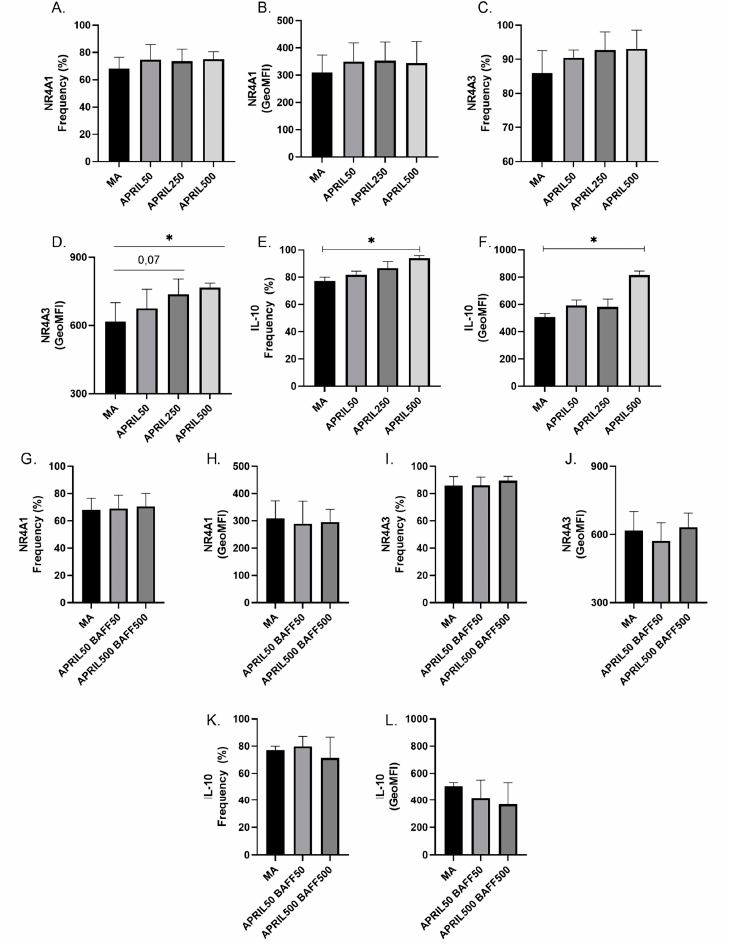
Figure 6. APRIL upregulates expression levels of immunoregulatory markers such as NR4A1, NR4A3 and IL-10 by blood marginal zone precursor-like (MZp) B-cells. Relative frequencies of MZp